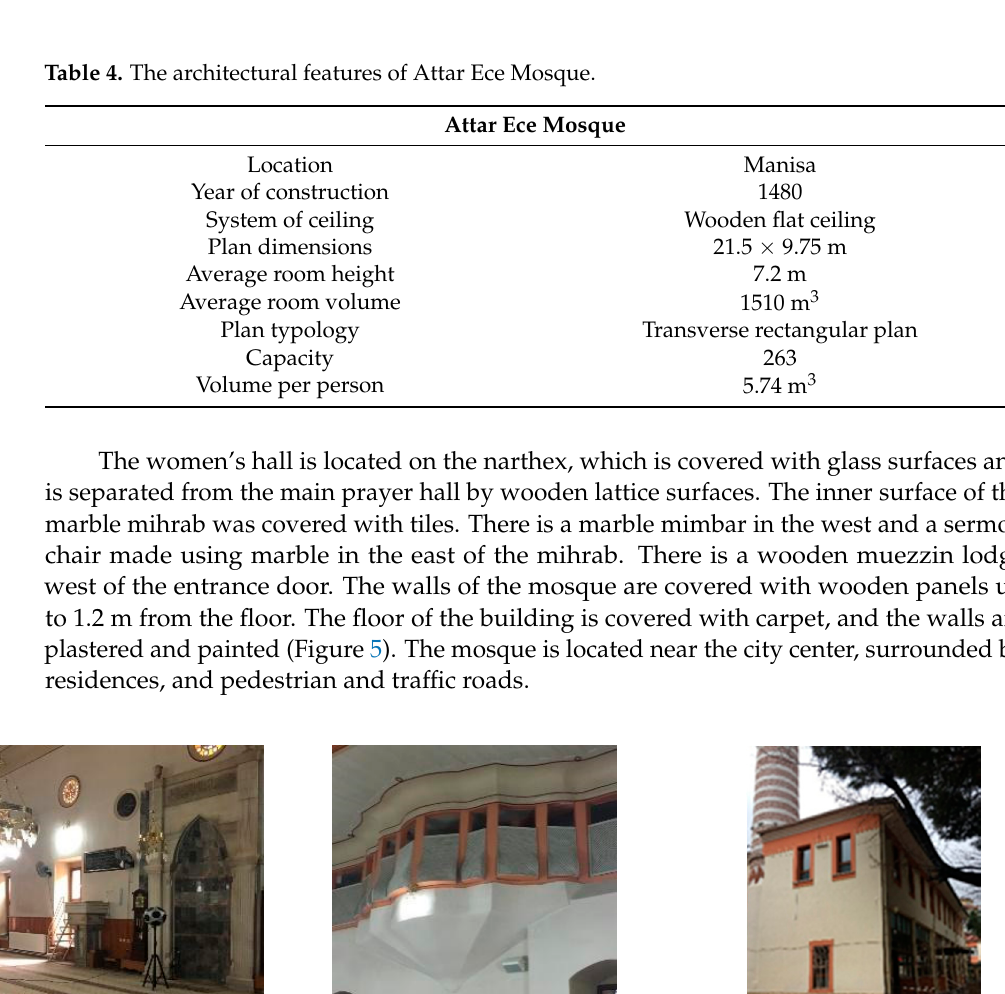
7 Figure 4. Main prayer hall and side section of Çe ş nigir Mosque (photos by the authors) .